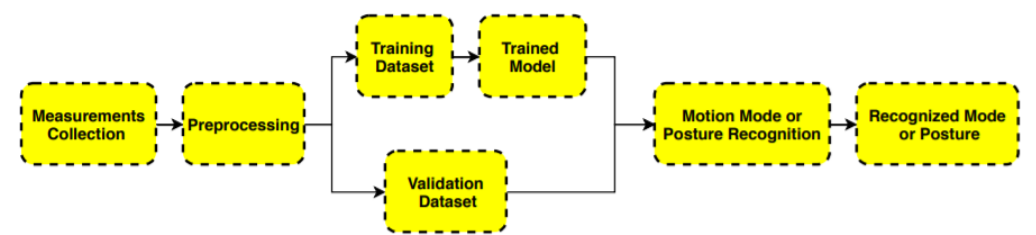
Figure 1. Procedure of